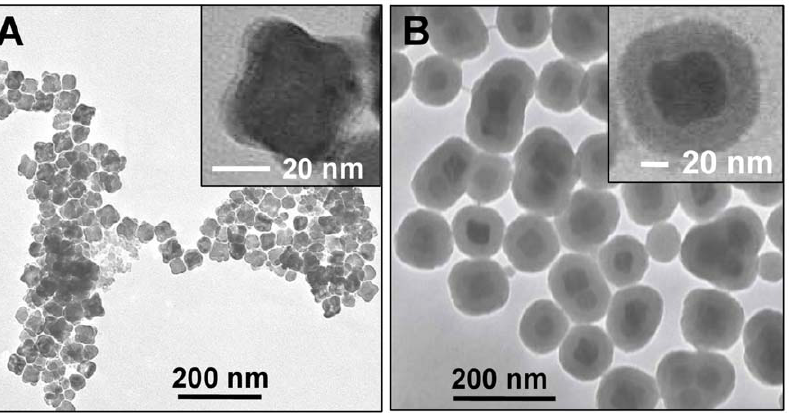
Figure 1. TEM images of (A) Mag and (B) Mag@SiO2 core-shell nanoparticles. Insets show the respective higher resolution TEM images.